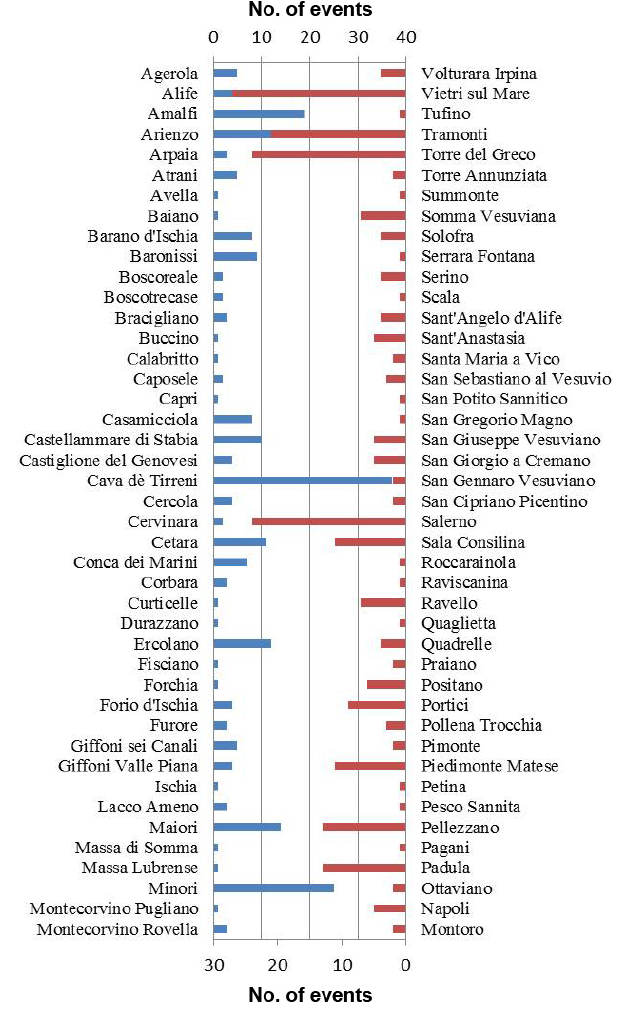
Figure 7. Recurrence of alluvial events in the municipalities.